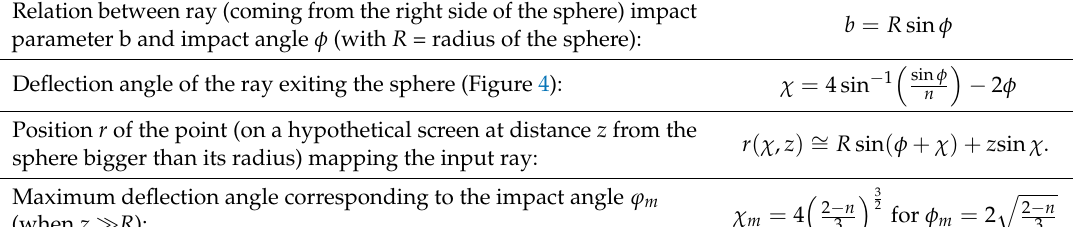
Table 2. list of main optical parameters considered in ray tracing simulations.